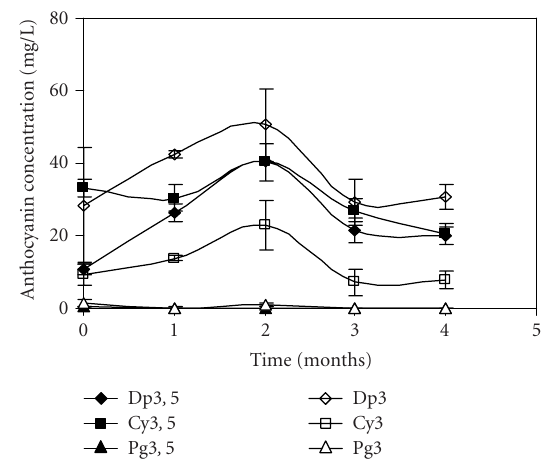
Figure 4. Evolution of delphinidin 3,5-diglucoside (Dp3,5), cyanidin 3,5-diglucoside (Cy3,5), pelargonidin 3,5-diglucoside (Pg3,5), delphinidin 3-glucoside (Dp3), cyanidin 3-glucoside (Cy3), and pelargonidin 3-glucoside (Pg3) concentration in “As- saria” pomegranate juice from fruits treated with Brillaqua wax, during storage at 5 ◦ C. The concentrations of anthocyanins were calculated from standard curves of Dp3,5; Dp3; Cy3,5; Cy3, Pg3,5, and Pg3. Bars represent standard deviations of four repli- cates.